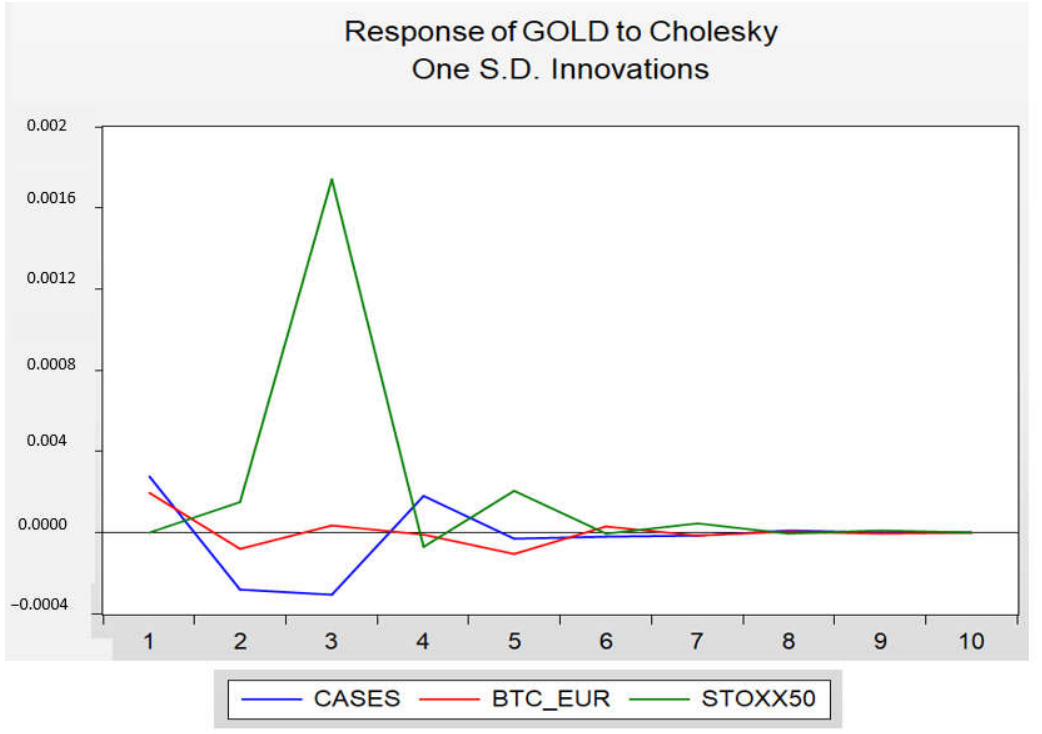
Figure 7. Impulse response of gold.